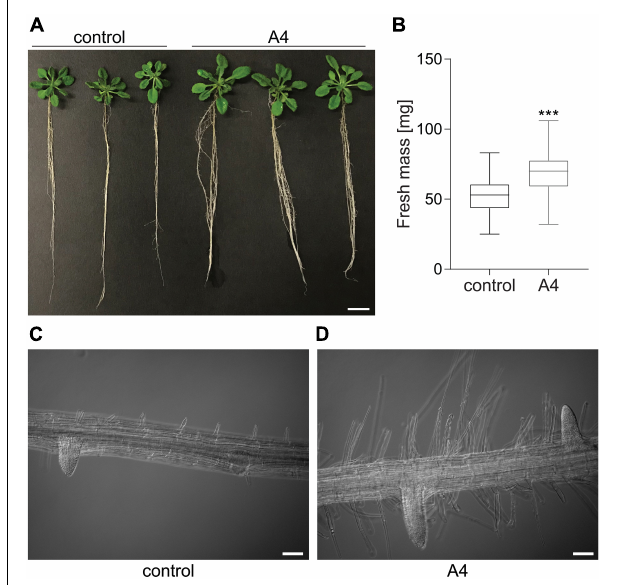
FIGURE 2 | Effect of endophytic strain A4 on Arabidopsis thaliana (A) Photo taken after 2 weeks postinoculation in comparison to the control. Scale bar = 1 cm. (B) Fresh mass of seedlings compared to the control (one-way ANOVA, Tukey’s multiple comparisons test, *** p ≤ 0.001), n = 41. (C,D) Differences in the root after 2 weeks of inoculation with A4 in contrast to the control. Scale bar = 0.2 mm. Control for all experiments: mock (infiltration buffer)-treated